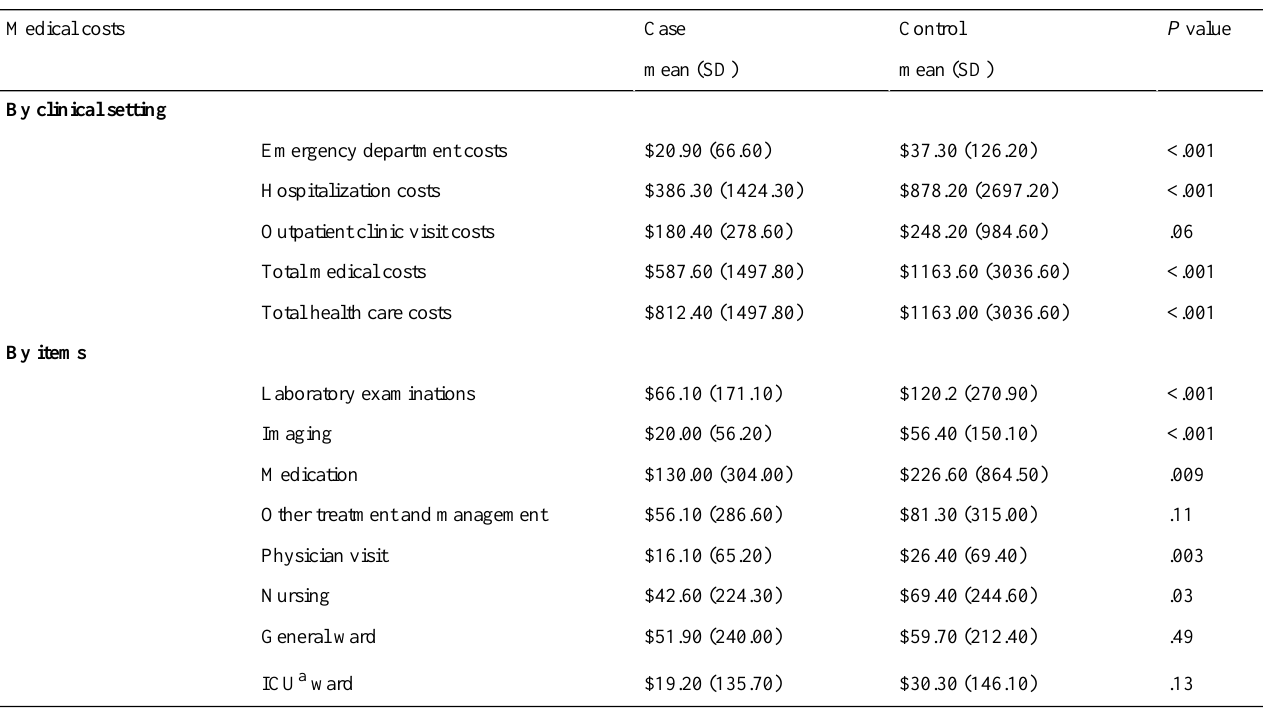
Table 5. Medical cost (US$ per patient/month).